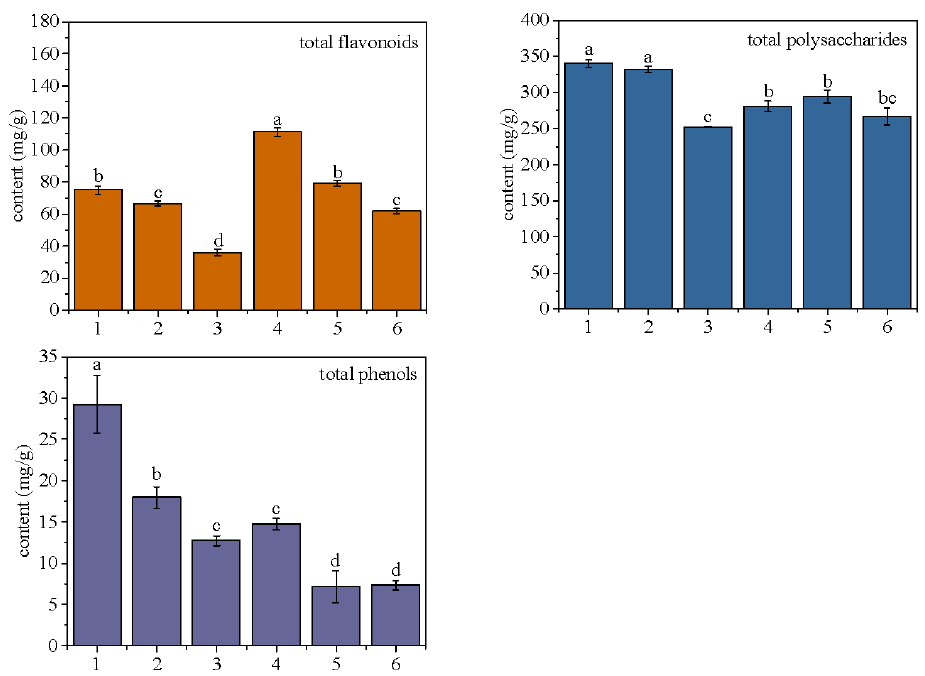
Figure 2. Mass fraction of Bletilla striata flowers mosaic flavonoids, polysaccharides, and total phenols. Note: Different alphabets indicate statistical differences between groups, and the same alphabets indicate no statistical differences between groups.